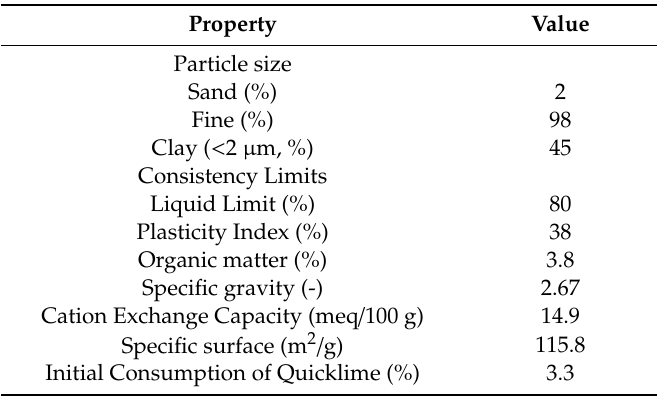
Table 1. Soil Characteristics.